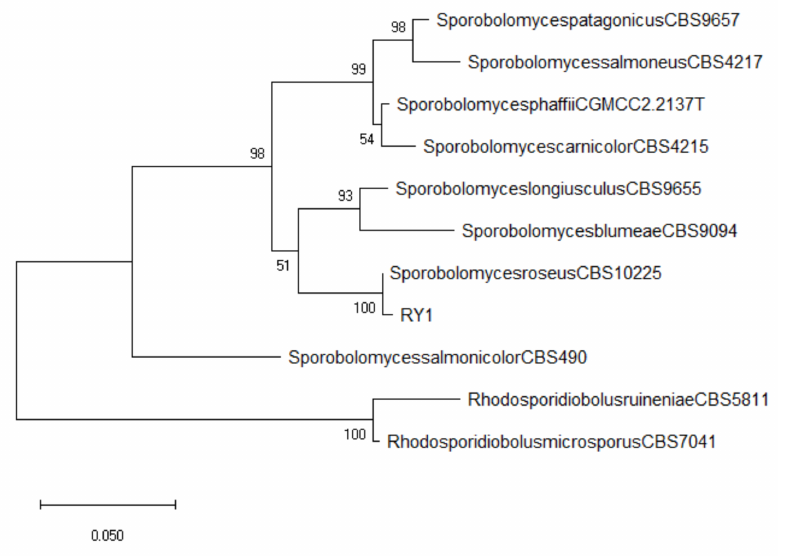
Figure 1. Phylogenetic tree based on the ITS sequences of reference strains of Sporobolomyces spp. plus the isolate RY1 from this study. Numbers on nodes represent the maximum likelihood bootstrap percentages. Branch lengths are proportional to the number of nucleotide substitutions and measured using the bar scale (0.050). Type strains are indicated with a